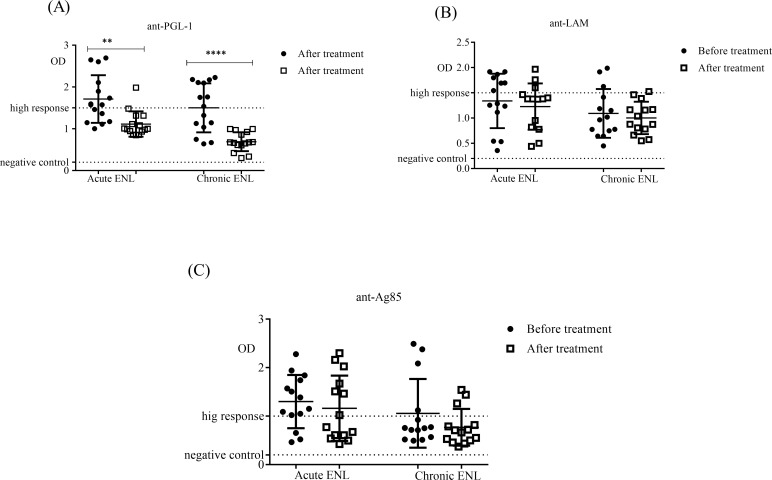
Serological responses to antigens in patients with acute and chronic ENL before and after prednisolone treatment.(A): response to M. leprae PGL-1 antigen; (B): response to M. leprae LAM antigen; (C): response to M. leprae Ag85 antigen; Number of ENL = LL = 25; Statistical test: Mann-Whitney unpaired test (U). * P≤0.05; **** P<0.0001. Scatter plots show median ± interquartile range.